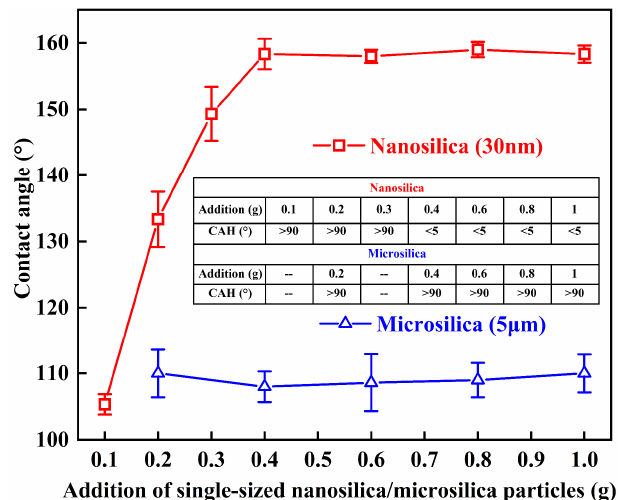
Figure 5. CAs of silica-filled A-PDMS-modified epoxy coatings with various additions of single-sized nanosilica and single-sized microsilica. The error bar is one standard deviation. CAH values of the coating with nanosilica and microsilica (inset).